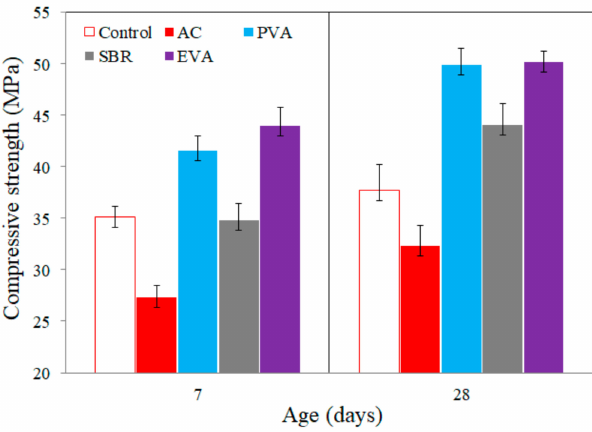
Figure 2. Compressive strengths for the PCMs and control mortar measured at seven and 28 days.